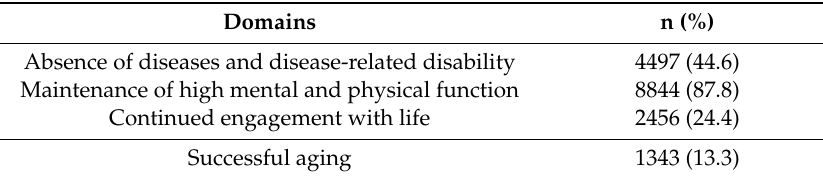
Table 3. The Proportion of Successful Aging, N =